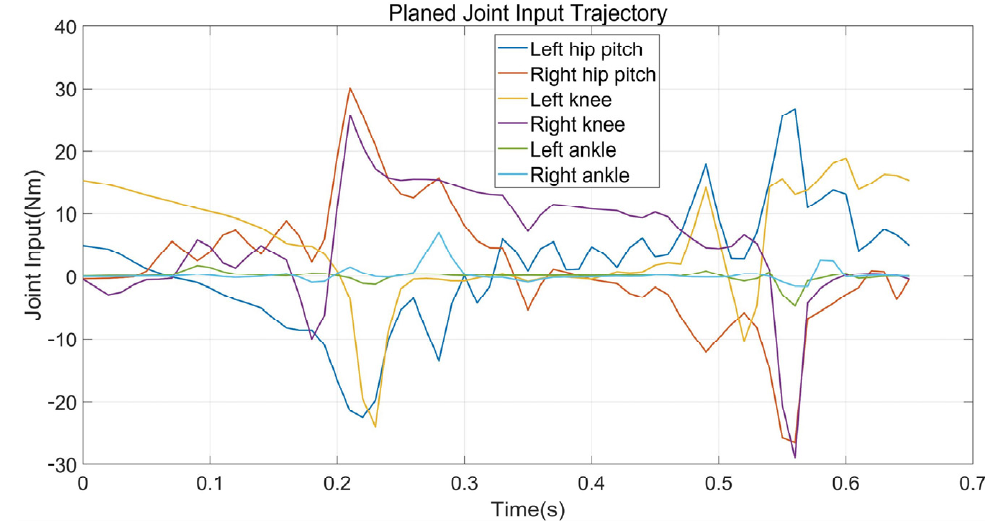
Figure 11. The planned input trajectories of planar walking on quincuncial piles.